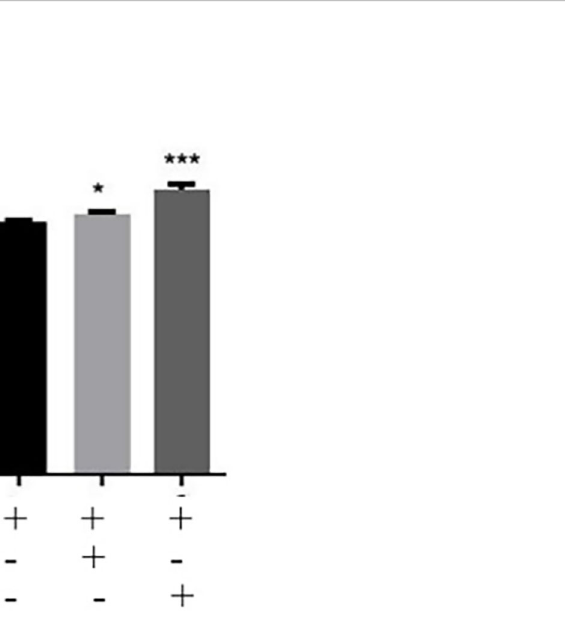
FIGURE 8 Effect of drugs on hemoilsin levels. KB, blank control group, CTX:model group;Zun C, zunyimycin C group; *: P < 0.05;***: P <